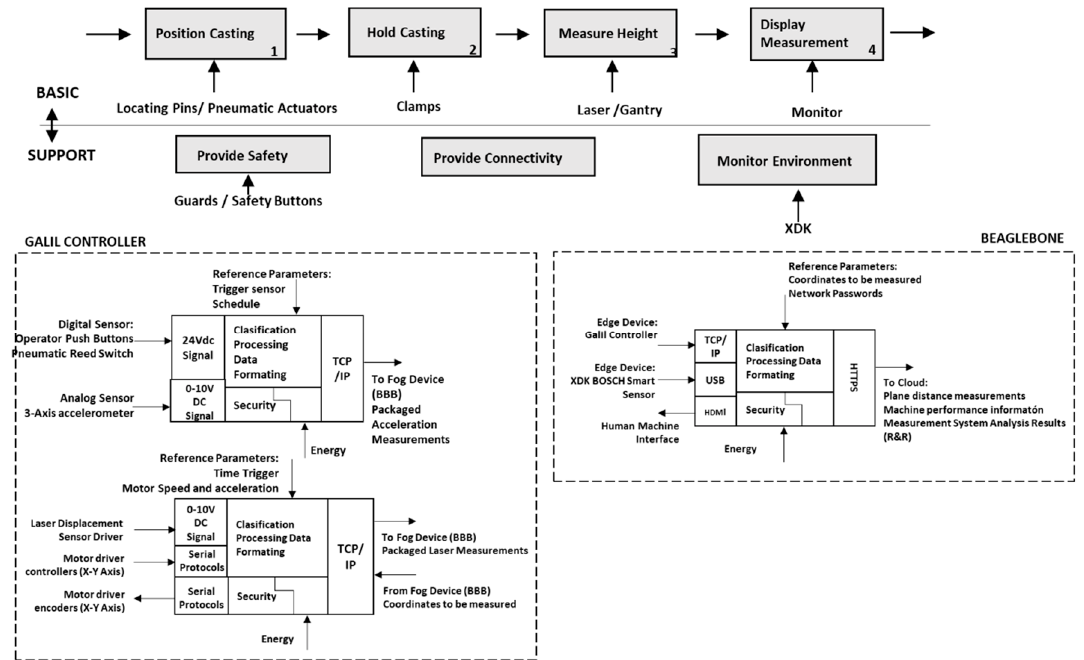
Figure 11. Integrated function diagram. Functions that provide Connectivity are shown at the bottom.